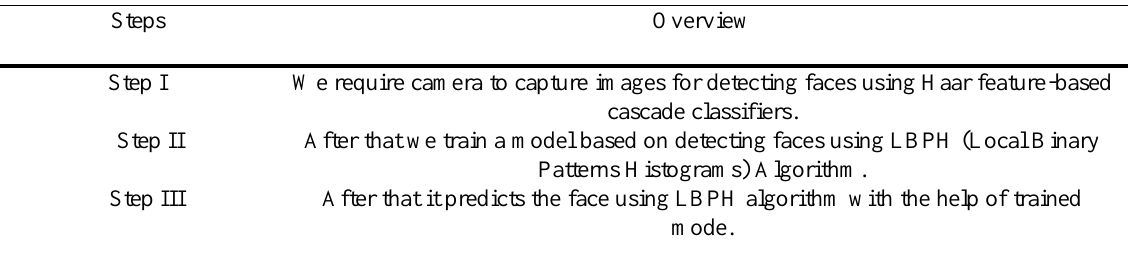
Table 2. Proposed local binary patterns histogram (LBH) method.